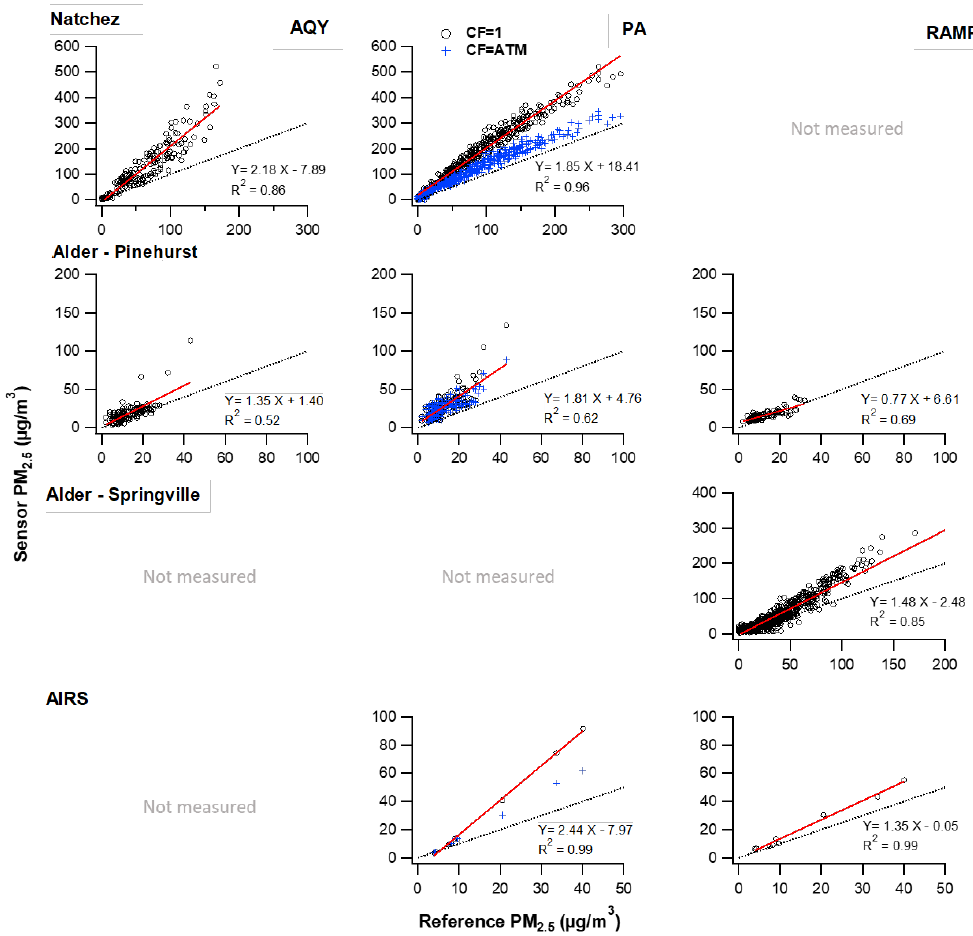
Figure 2. Scatter plot of sensor hourly averages compared to the reference for smoke impacted times. Red lines show linear least-squares fit; black lines show a one-to-one relationship. Columns correspond to the sensor type and rows correspond to the measurement location. Note the varying concentration range measured at each location.